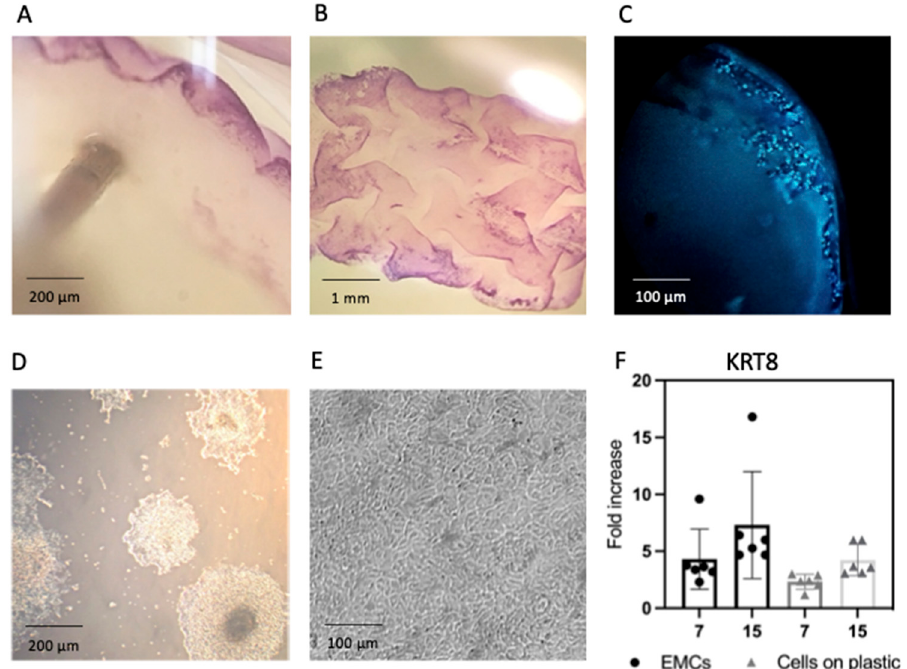
Figure 2. Primary epithelial cells derived from human bladder carcinoma were found to adhere to the scaffold basement membrane. Human primary urothelial cells from bladder carcinoma cultured on bladder scaffolds stained with MTT after ( A ) 7 days and ( B ) 15 days, and they were stained with ( C ) DAPI after 7 days. Human primary urothelial cells from bladder carcinoma cultured on plastic after ( D ) 7 days and ( E ) 15 days. ( F ) Cells grown on plastic or bladder scaffolds expressed the tissue specific marker KRT8. Fold increase of samples was calculated by normalizing with TBP and original bladder carcinoma at day 0 was used as control. Scale bars represent 200 µ m for ( A ) and ( D ), 1 mm for ( B ), and 100 μ m( C ) and ( F ).